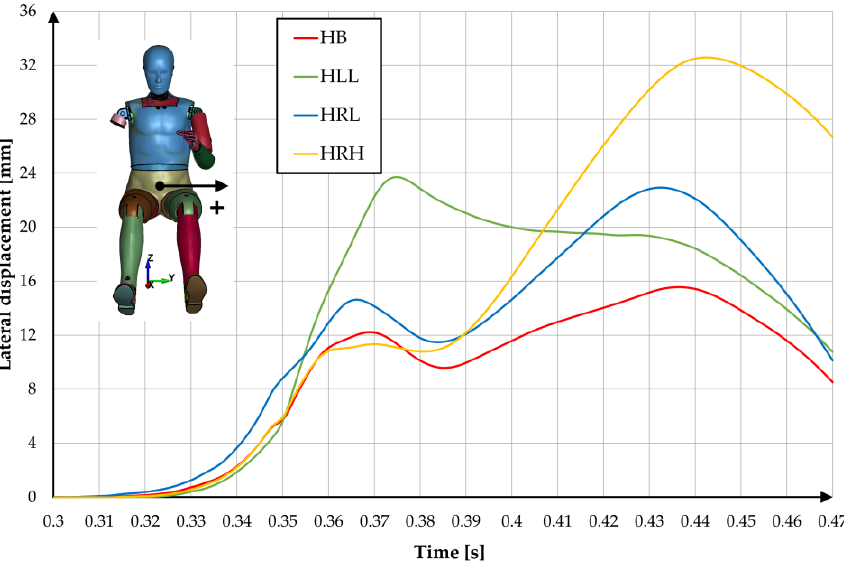
Figure 9. Lateral displacement of dummy H-point.